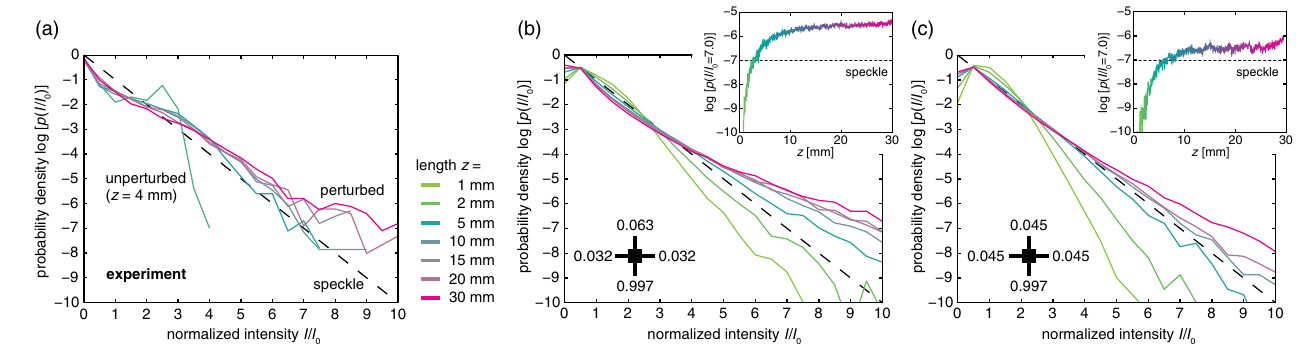
FIG. 2. Comparison of experimental and numerical results in the linear regime. (a) Histogram of the normalized intensity distribution as obtained experimentally from the rear facets of the samples. The shortest sample ( L ¼ 4 mm) is unperturbed, all other samples are perturbed. For L ¼ 5 and 10 mm, the trend follows the exponentially decaying curve of a speckle distribution [dashed black line; compare with Eq. (1)]. For longer propagation lengths ( L ¼ 15 , 20, 30 mm), extreme events are more probable than anticipated from a random distribution. (b) Histogram of normalized intensity distribution at different propagation lengths z from simulations based on the stray matrix method with plane wave excitation and weak, but prevailing backscattering. The exact scattering amplitudes are stated in the pictogram displayed in the bottom left-hand corner (clockwise, starting from the top): backward j r j , leftward j r ⊥ j , forward j t j , and rightward j r ⊥ j (see also Fig. 5). For increasing z the probability distribution quickly surpasses a speckle distribution, before asymptotically approaching a heavy-tailed limiting function between z ¼ 20 and 30 mm. See also the inset for the dependence of the probability density at a fixed intensity value I ¼ 7 . 0 I 0 on z . (c) Numerical results with less dominant backscattering. For intermediate propagation lengths the frequency of extreme events is greatly diminished. However, partial diffuse reflection at the rear facet increases the probability of extreme events in its vicinity (also visible in the